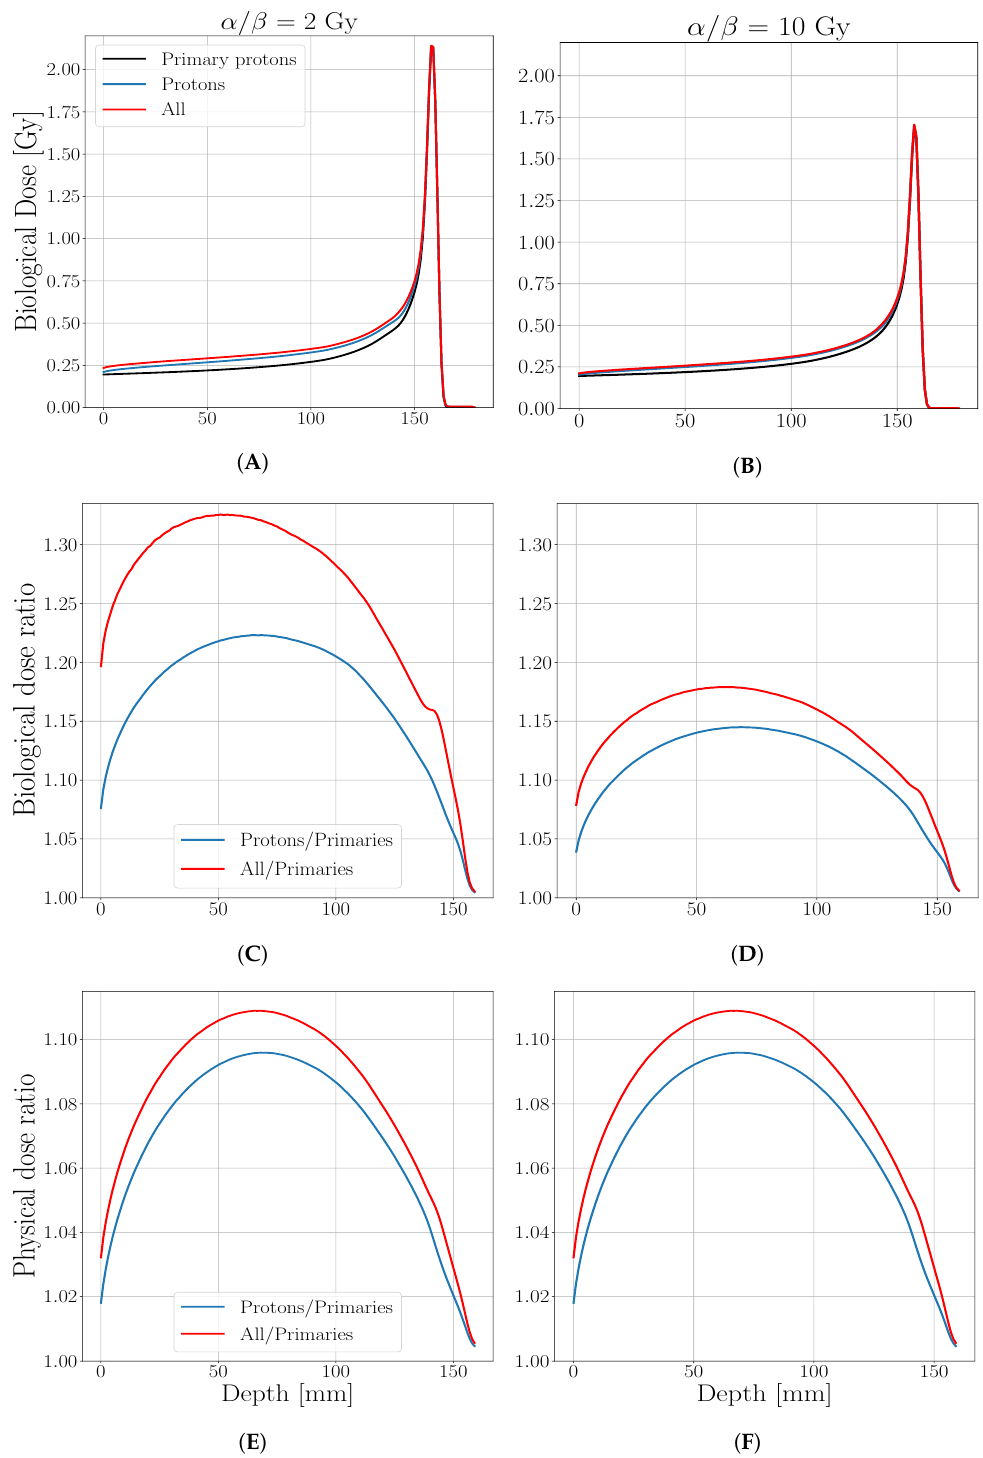
Figure 2. Biological dose as a function of water depth where the black curve is calculated considering the contribution of primary protons only, the blue one of all protons and the red curve all particles (protons and target fragments), ( A , B ). The panels ( C , D ) report the ratio between the biological dose obtained considering all protons over the biological dose obtained considering only primary protons (blue) along with the ratio between the biological dose obtained considering all produced particles over the biological dose obtained considering only primary protons (red). ( E , F ) reports the same ratios but for the physical dose. The cited results are calculated for a tissue characterized by an α / β of 2 Gy, ( A , C , E ) and α / β of 10 Gy ( B , D , F